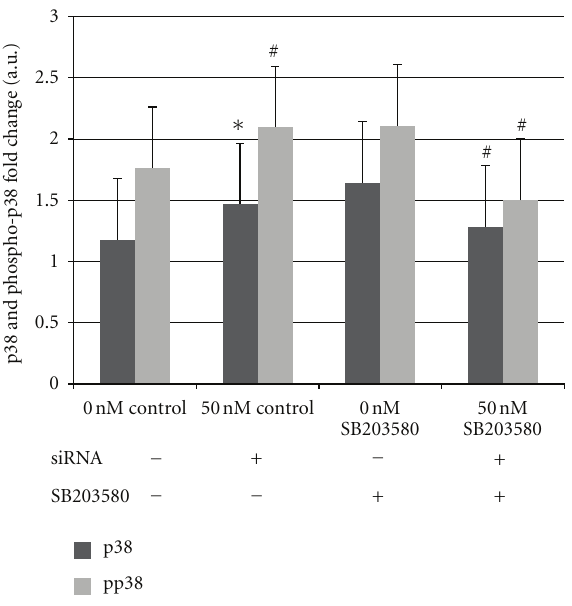
Figure 5: C2C12 cells were di ff erentiated from myoblasts to myotubes as described in the Materials and Methods section.